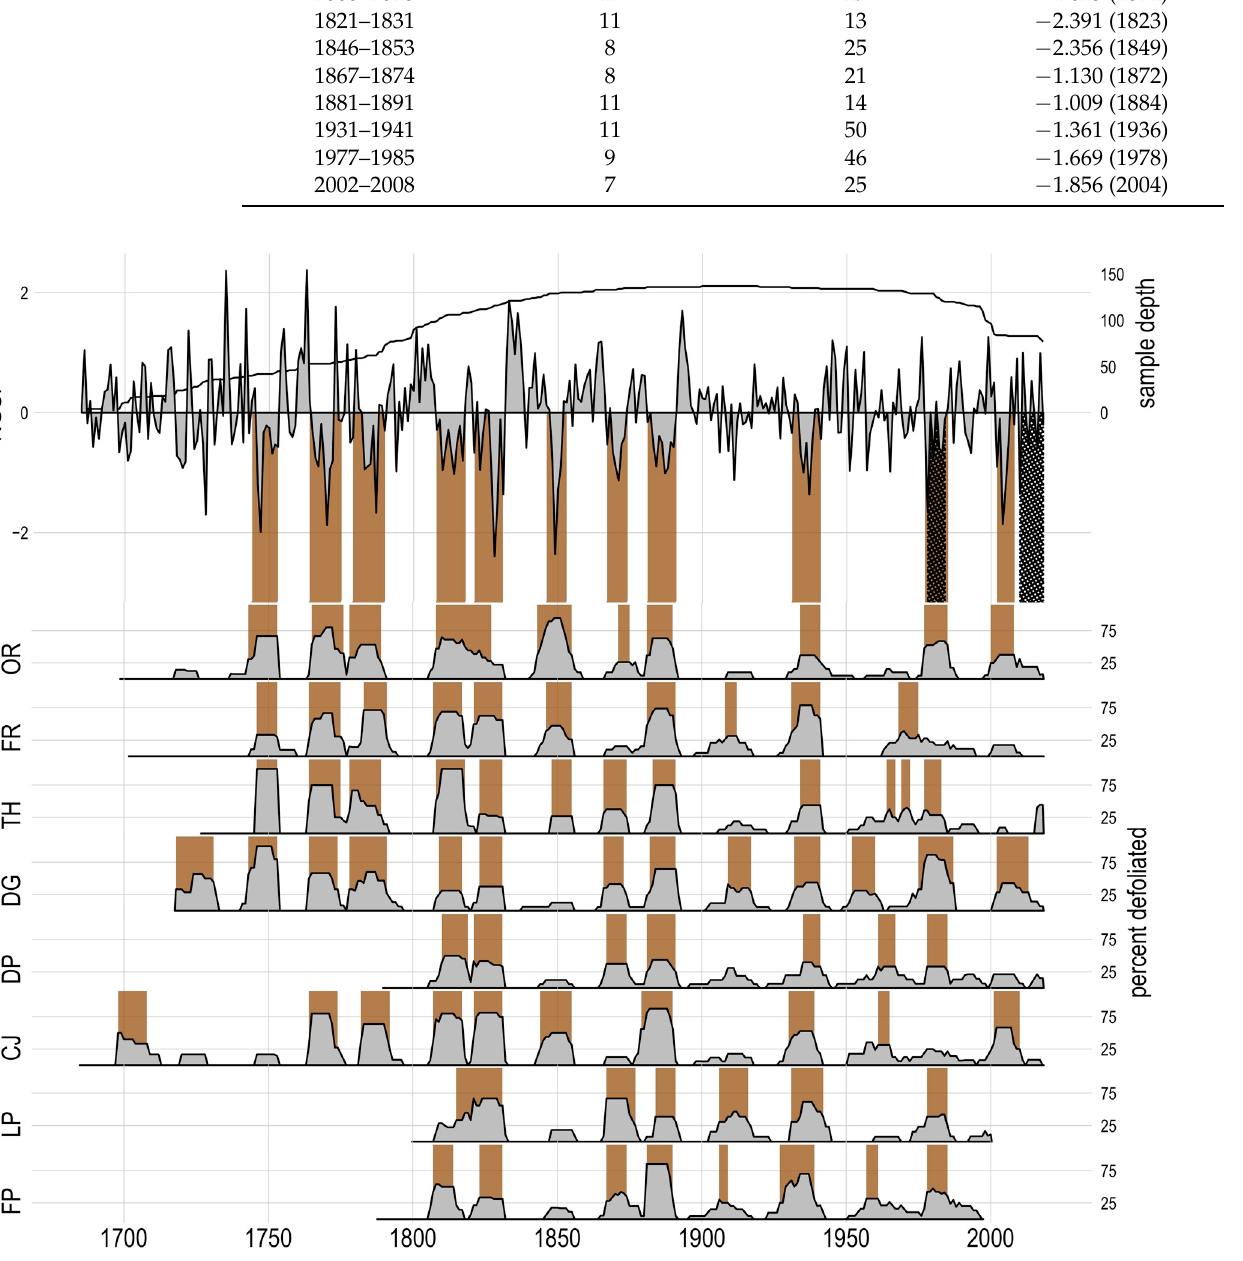
Figure 5. Pandora moth outbreaks at the landscape ( top ) and site ( bottom ) scales. Sites are ordered from north ( top ) to south. Brown bars represent inferred outbreak periods at the site or plateau scale and crosshatched regions are historically observed outbreaks. The landscape outbreaks are represented in normalized growth suppression index and the site outbreaks are percent of trees indicating a defoliation event by site with shaded regions representing site-wide outbreak